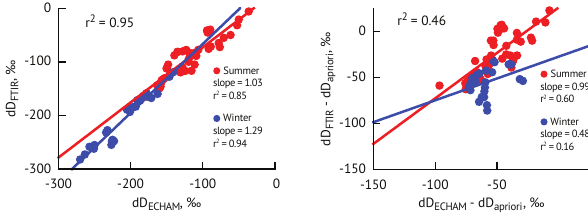
Figure 13. FTIR results comparison: (left panel) with columnar ECHAM5-wiso δ D v values and (right panel) with subtraction of all a priori variations.